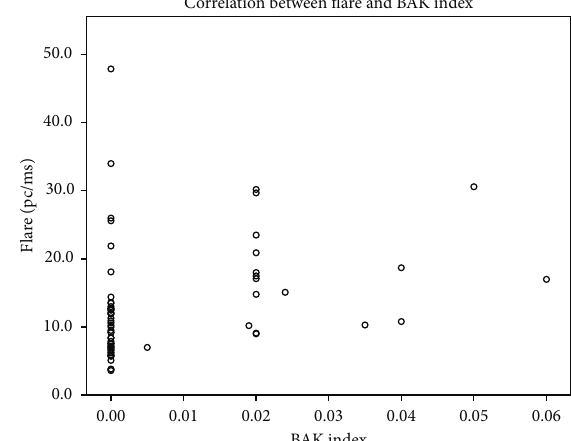
Figure 4: Correlation between flare and BAK index in the glau- coma group; a weak positive correlation (Spearman’s rho � 0.390, p � 0 .